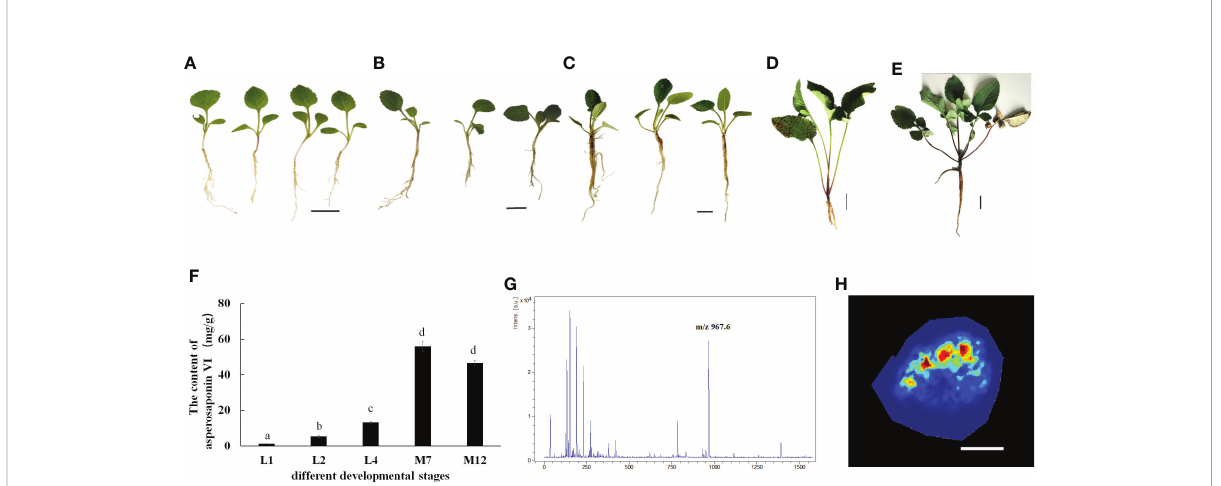
FIGURE 2 Accumulation Pattern of asperosaponin VI in root. (A – E) , the plants of D. asperoides in one leaf stage (L1), two leaf stage (L2), four leaf stage (L4), seven months (M7), one year (12M). Scale bars = 2 cm in (A – C) , Scale bars = 5 cm in (D, E) . (F) , the content of asperosaponin VI in (A – E) . The error bars represent the standard deviation with at least three biological replicates. Different lowercase letters denote signi fi cant differences by multiple comparisons using Statistix 8.0 software. (G) , the asperosaponin VI peak is most abundant (m/z 967). (H) Accumulation Pattern of asperosaponin VI in L2 root as observed by MALDI MSI. Scale bars = 1